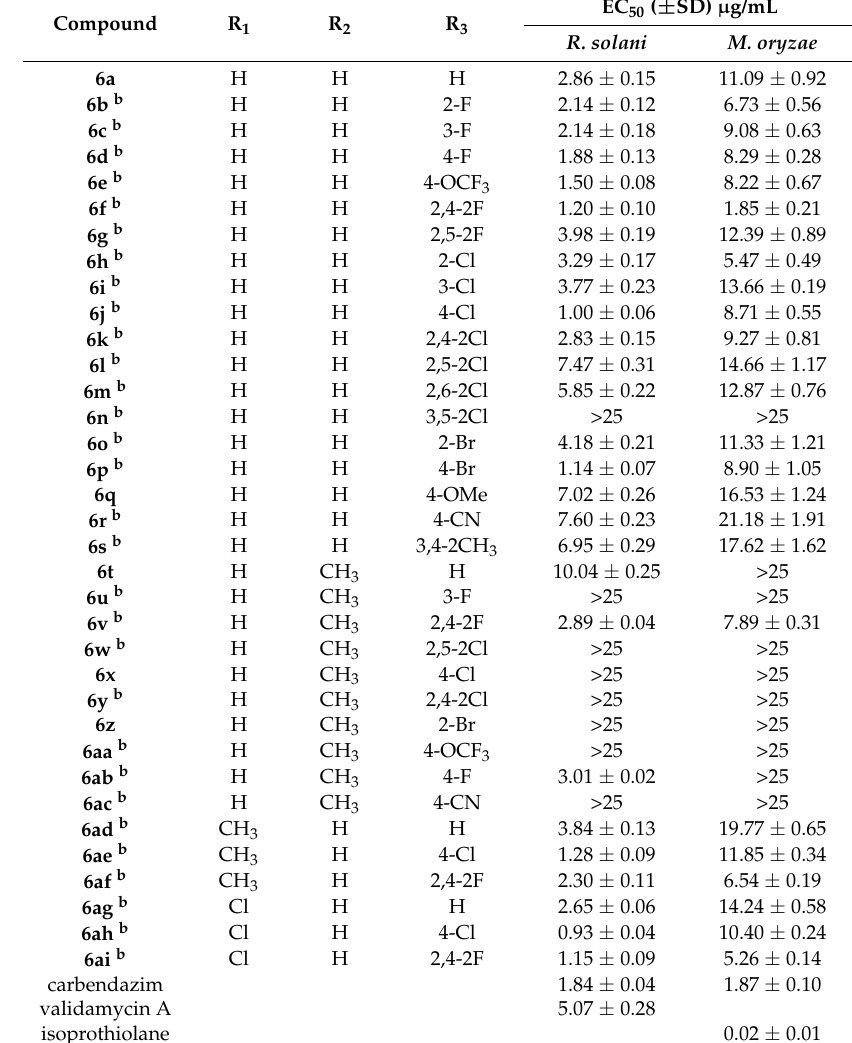
Table 1. Antifungal activity of compounds against two phytopathogens a .